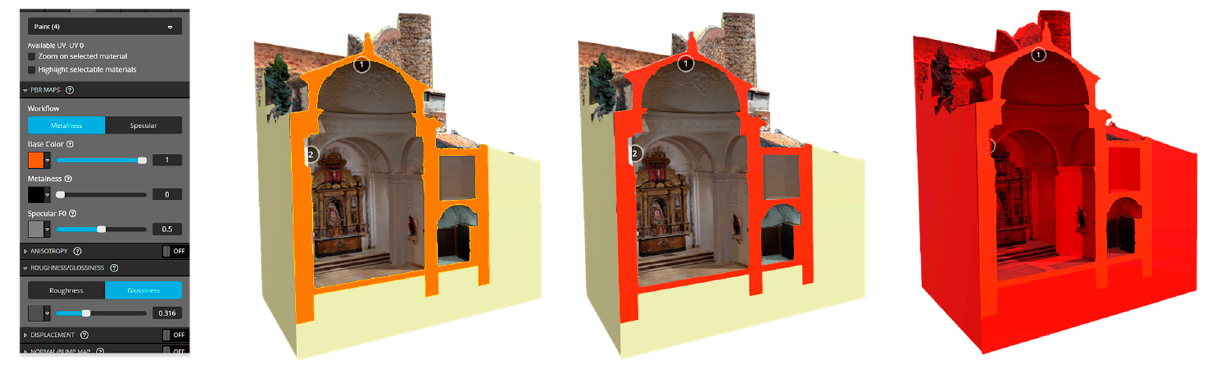
Figure 16. Different customizations in PBR of the preconfigured materials in activity I. Customization of the clipping region in orange and red and, finally, replacement of all texture maps by a solid red color.